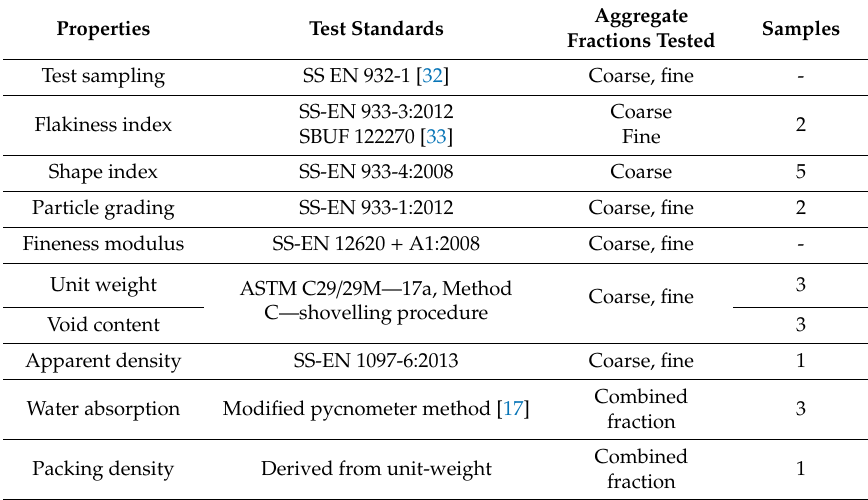
Table 2. Aggregate properties